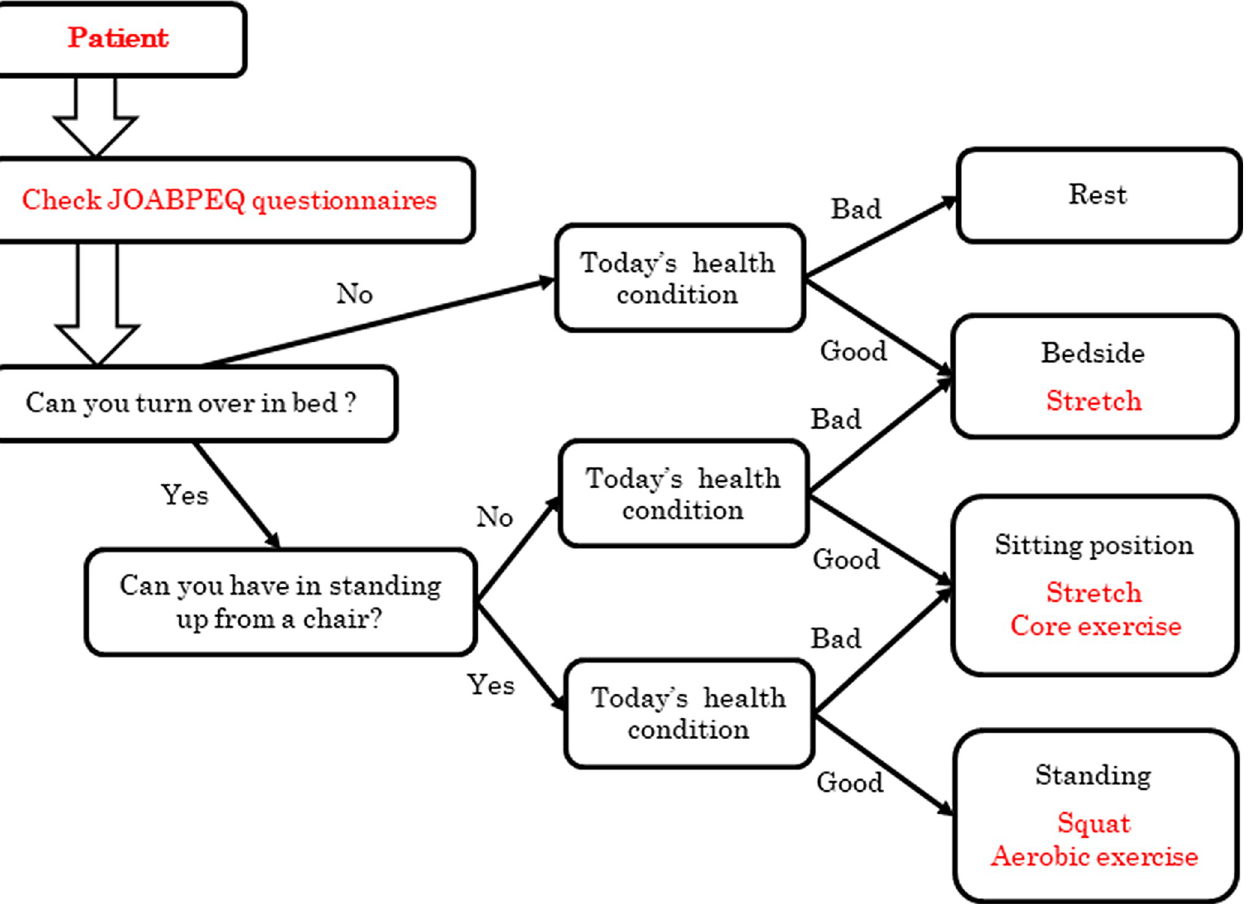
Fig 4. An informative description tree of treatment guidelines for physical therapy in patients with LDH.